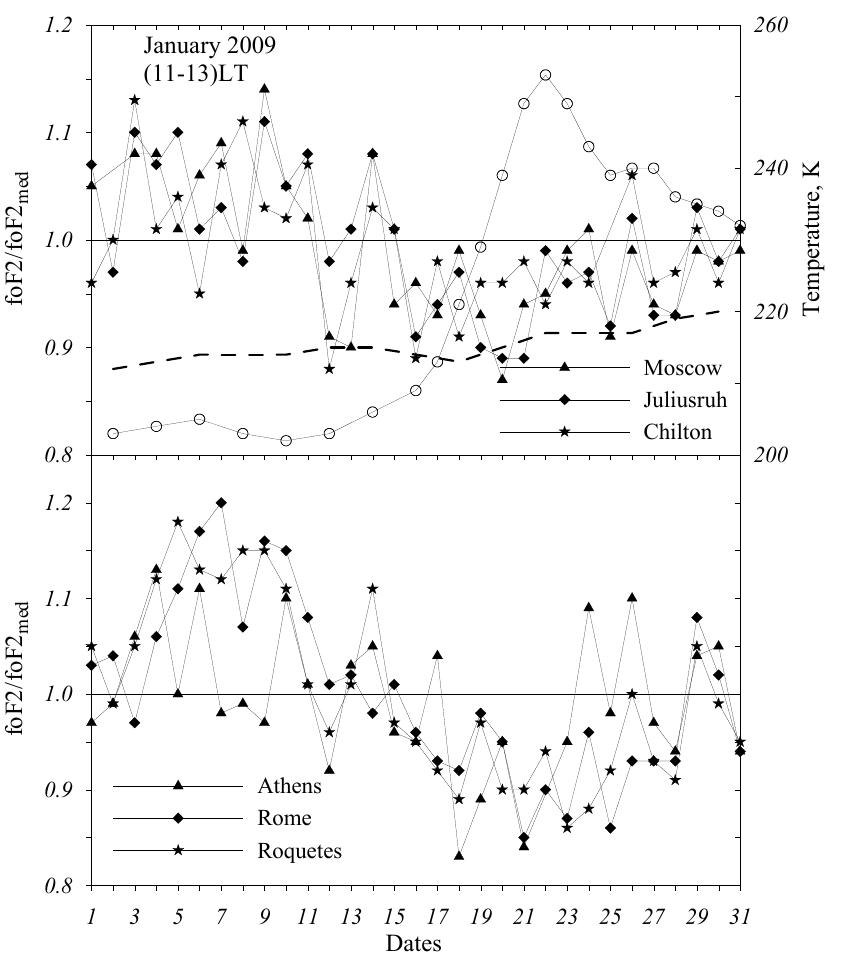
Figure 2. The f o F 2 /f o F 2med ratio for higher and lower latitude groups of stations during the SSW 2009 period. Solid lines indicate the monthly median level. Open circles—stratospheric (10 hPa) temperature at high latitudes (60–90°) N in January 2009. The dashed line represents the 30-year median value of the high latitude stratospheric temperature.